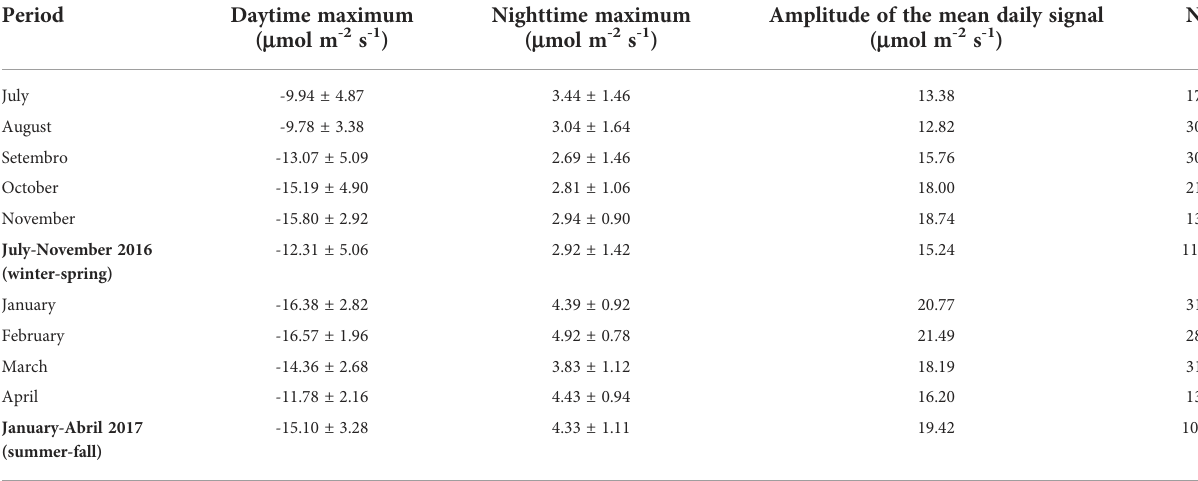
TABLE 2 Mean and standard deviation for the daytime (nighttime) monthly average of maximum (minimum) values of the CO 2 fl ux measured during both study periods.